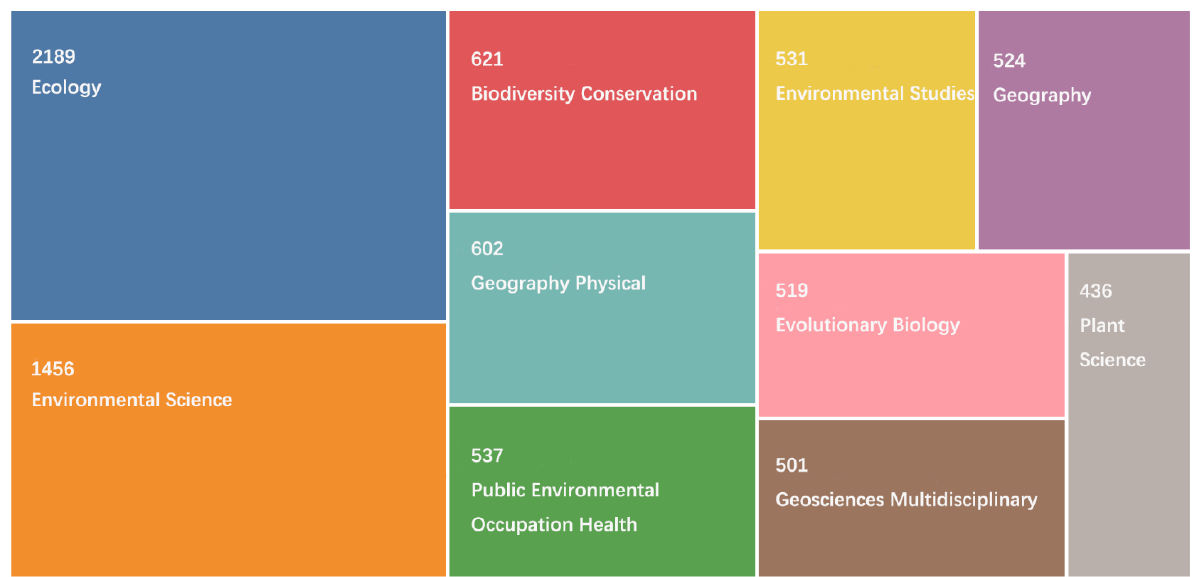
Figure 1. Top ten most productive disciplines for SA research.